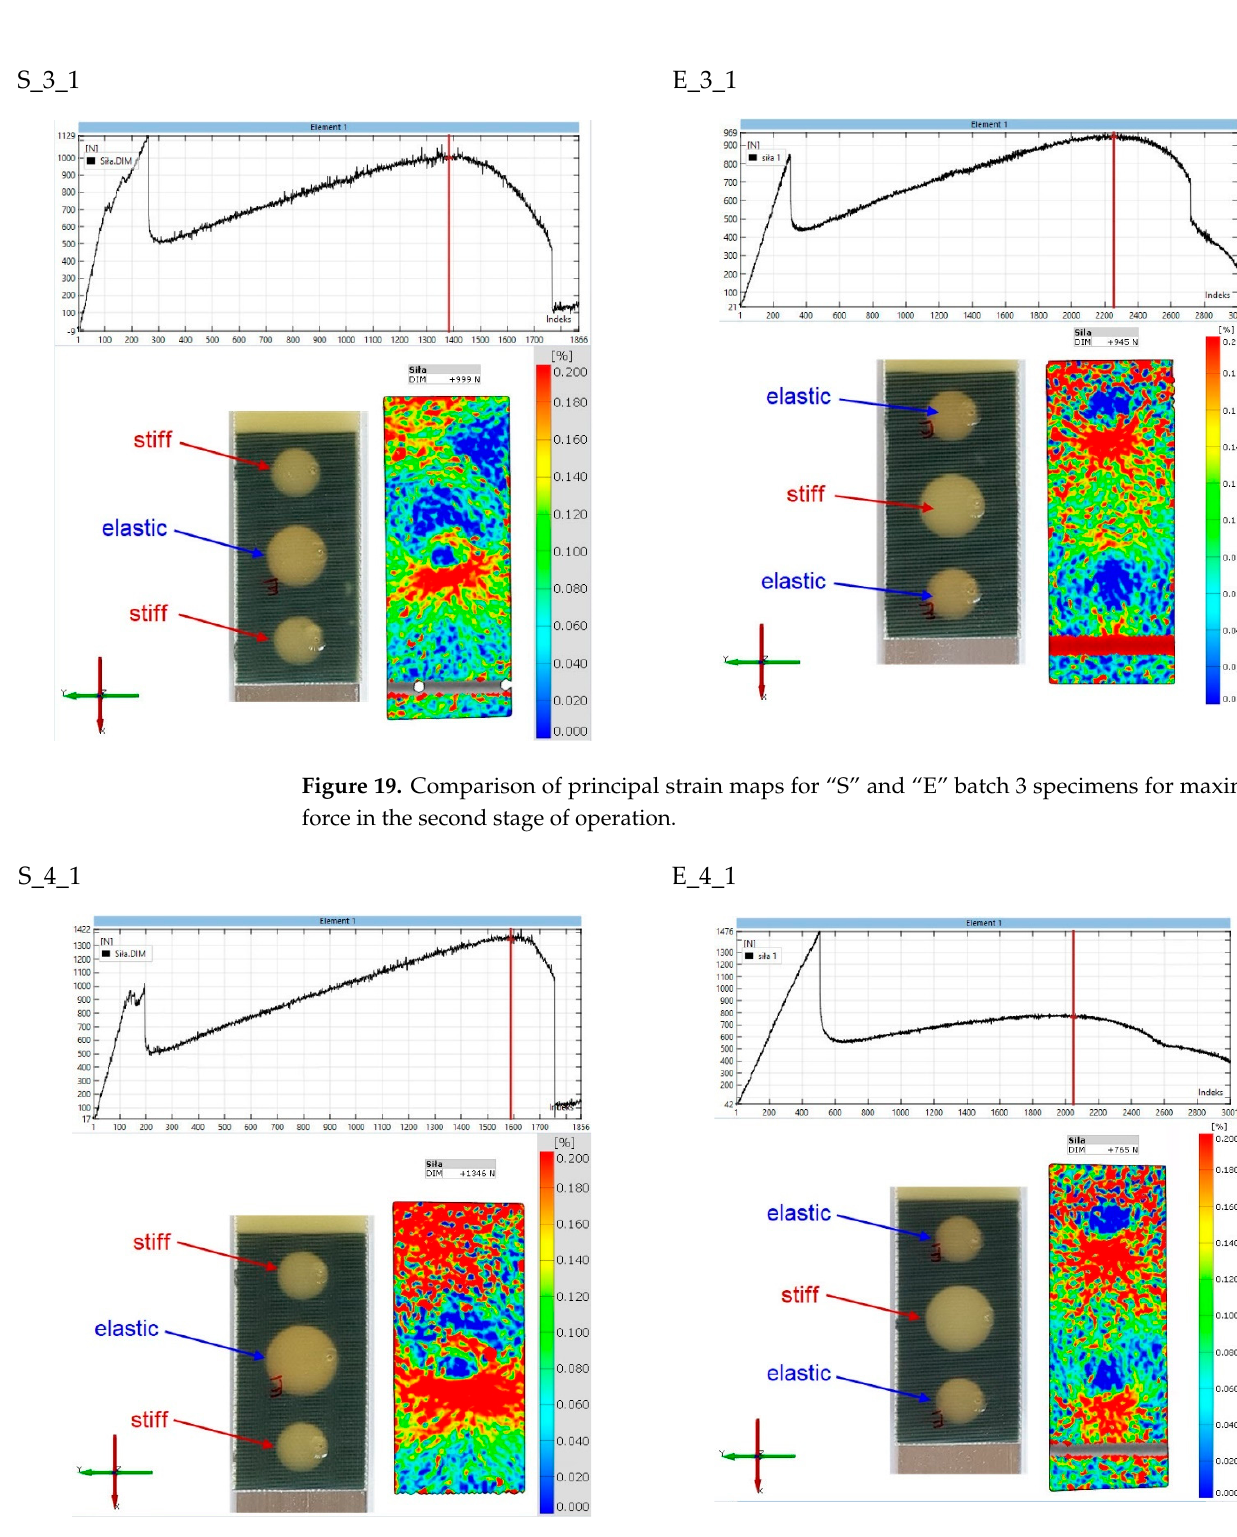
Figure 20. Comparison of principal strain maps for “S” and “E” batch 4 specimens for maximum force in the second stage of operation.